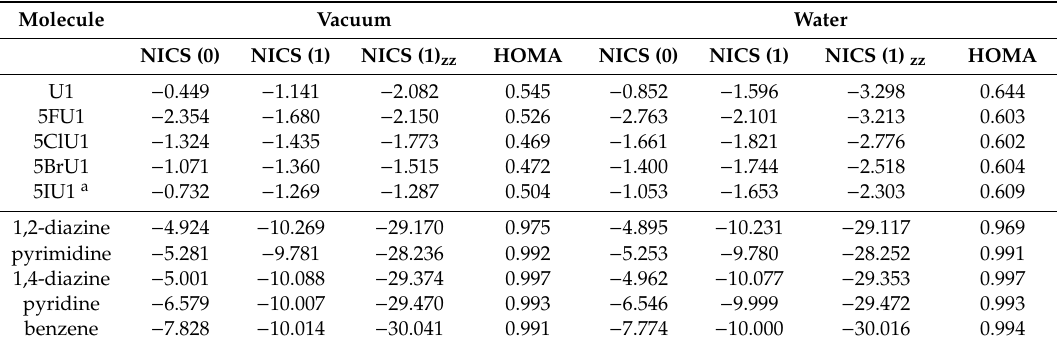
Table 2. B3LYP-D3 / aug-cc-pVQZ values of nuclear independent chemical shift (NICS) and harmonic oscillator model of aromaticity (HOMA) parameters for the most stable tautomer 1 of uracil, its 5X-derivatives, diazines, pyridine and benzene in the gas phase and water modelled with PCM. Molecule Vacuum